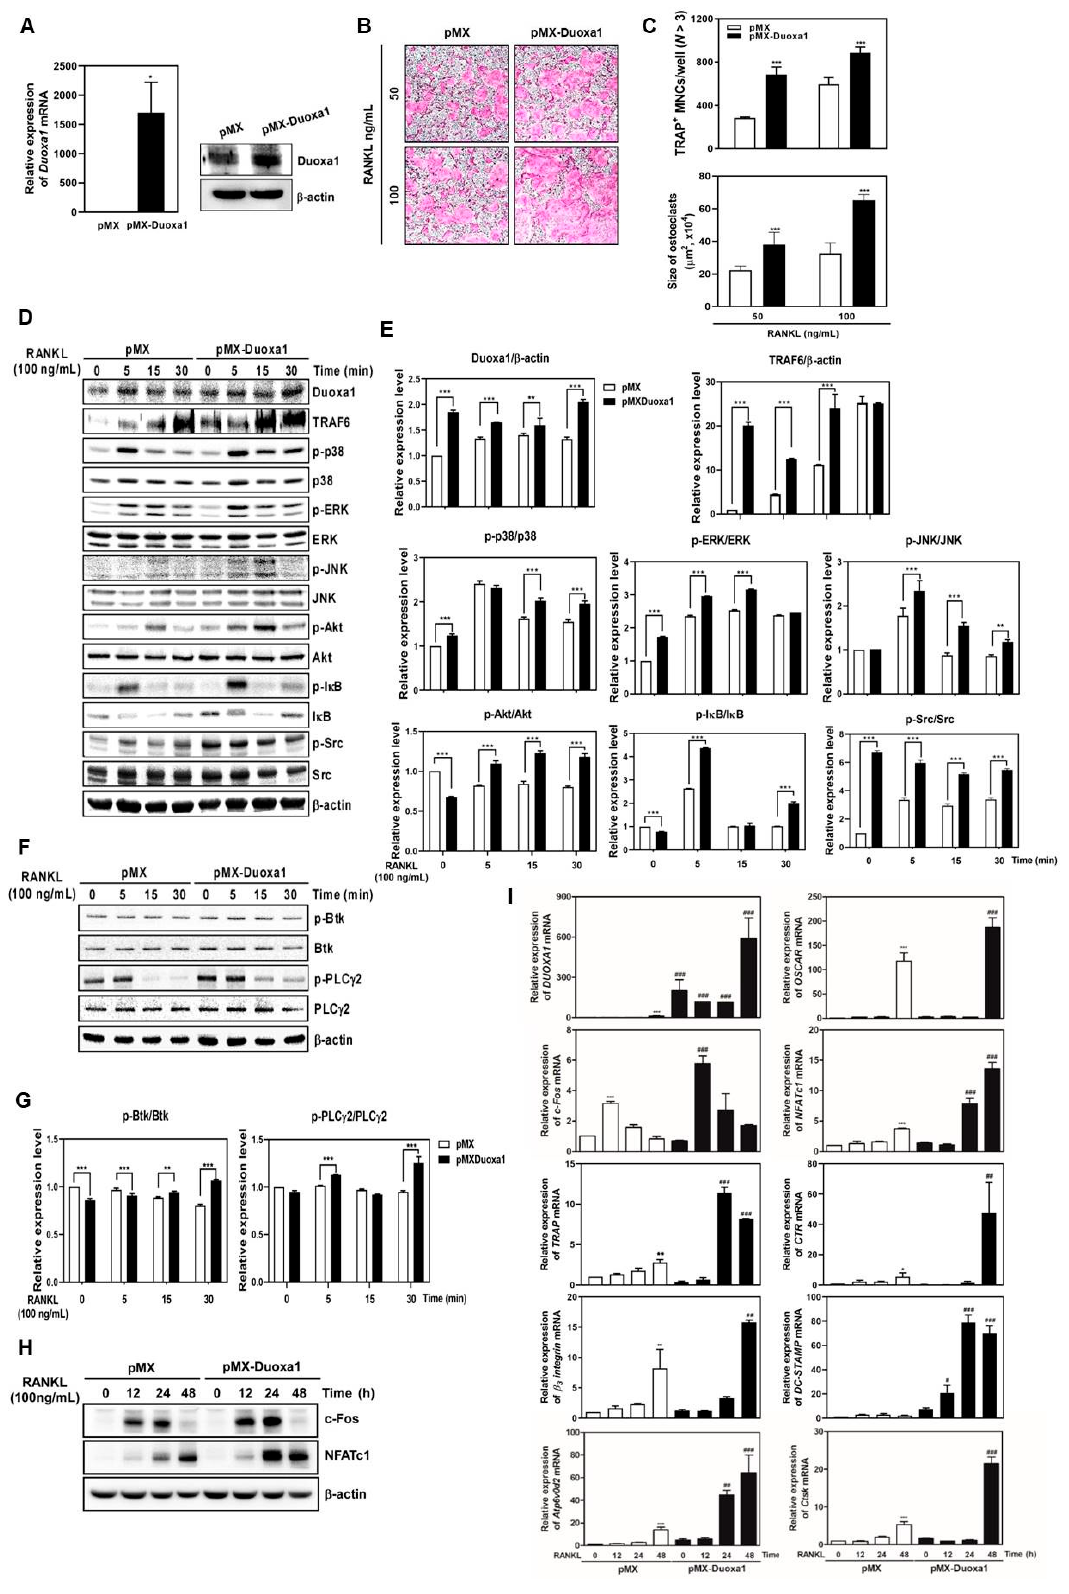
Figure 3. Overexpression of Duoxa1 enhances osteoclast differentiation by regulating the TRAF6-mediated signal molecules and osteoclast marker genes. ( A ) BMMs were transduced with the pMX or pMX-Duoxa1 retrovirus. Overexpressed Duoxa1 mRNA levels were observed by qRT-PCR and western blot analysis. * p < 0.05 versus the pMX. ( B , C ) BMMs were transduced with the pMX